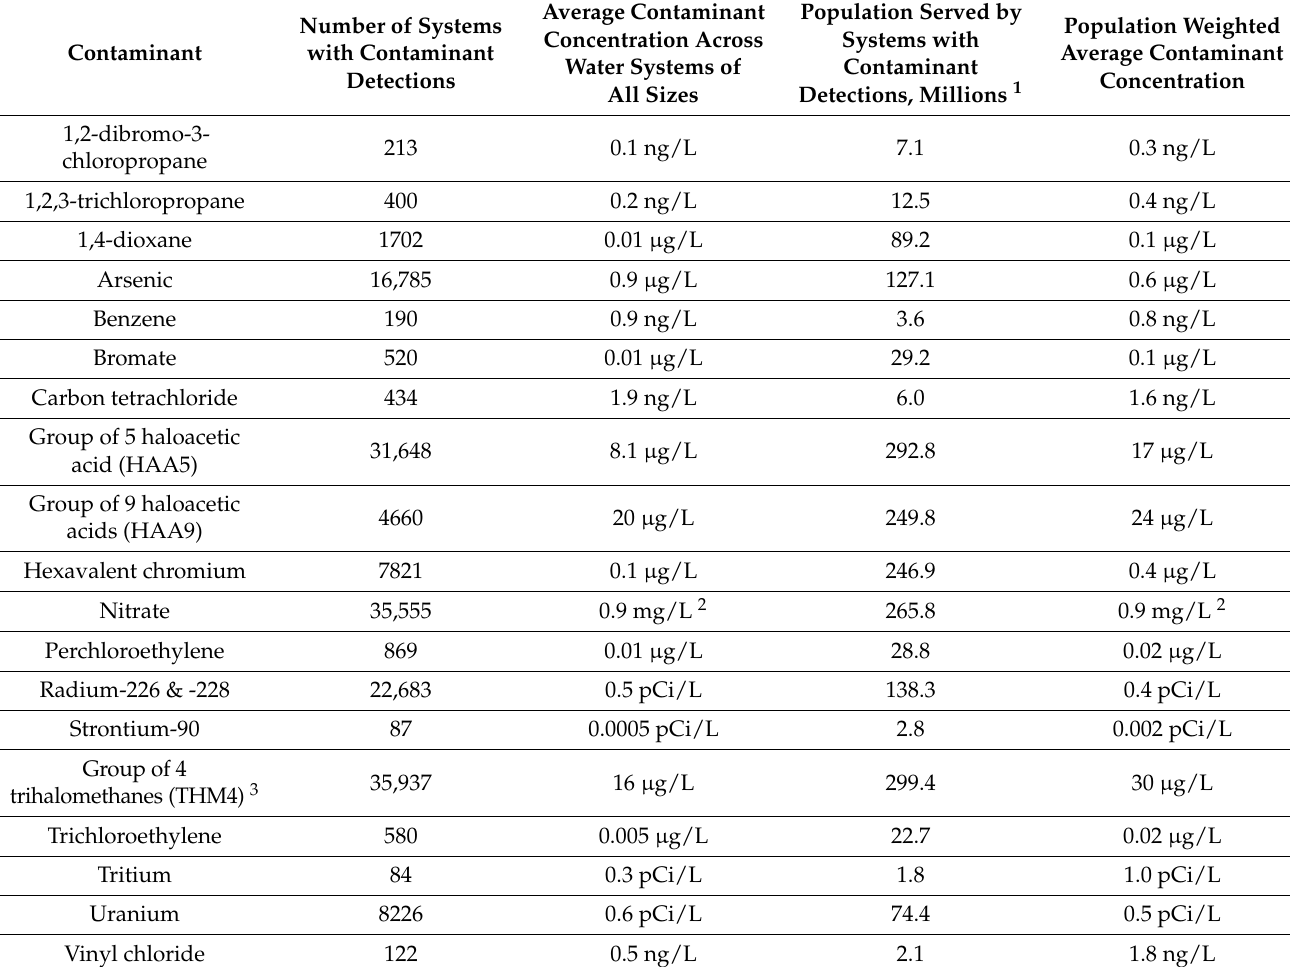
Table 1. Occurrence and average concentrations for contaminants included in this